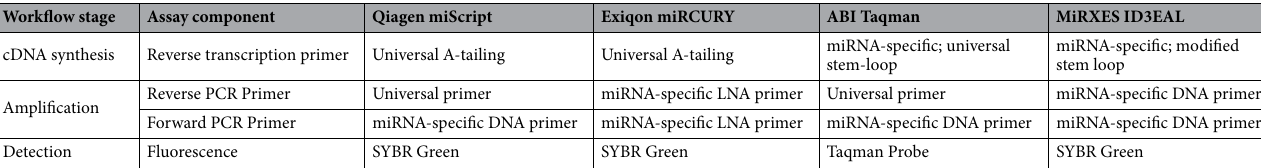
Table 1. Overview of qPCR